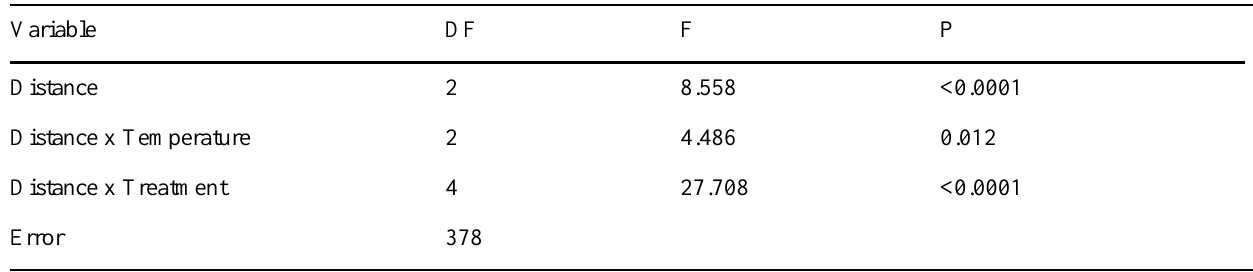
Table 2. Within-subjects, Type III ANOVA assuming sphericity for the effect of distance to the road, traffic, and temperature on deviation from a straight-line course toward the road. Treatment refers to control, low-traffic and high-traffic